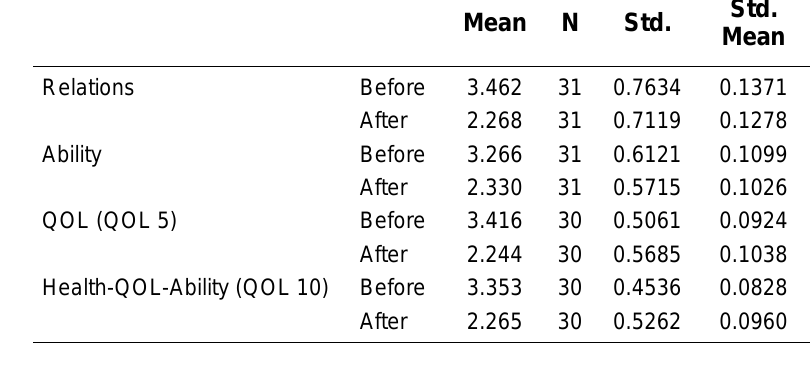
Study of 31 Patients where Therapy Changed their Ratings of Self-Evaluated QOL from Low to Not Low* (T-Test) Std. Mean N Std.